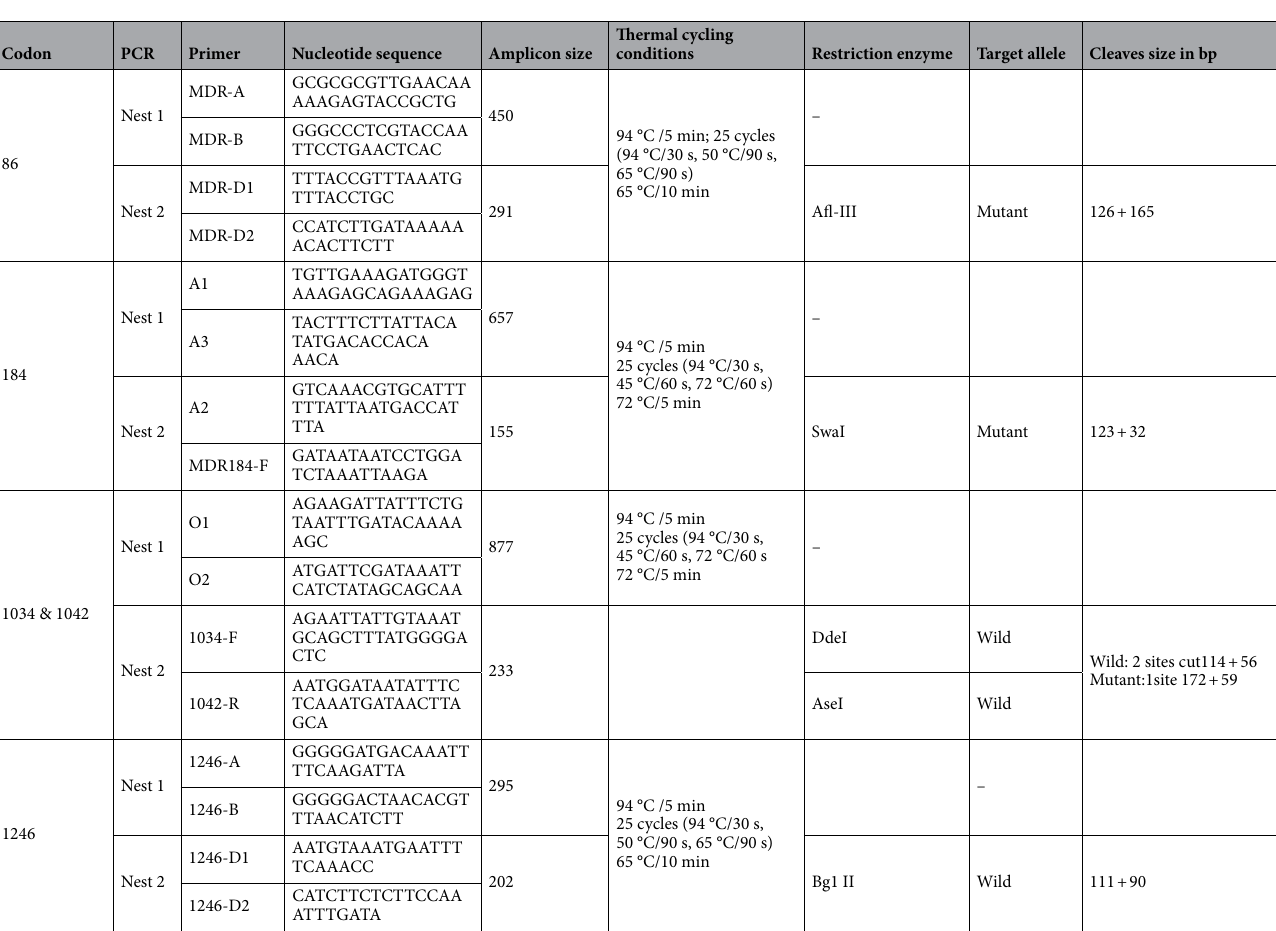
Table 4. Nested PCR–RFLP protocol for the detection of Pfmdr1 point